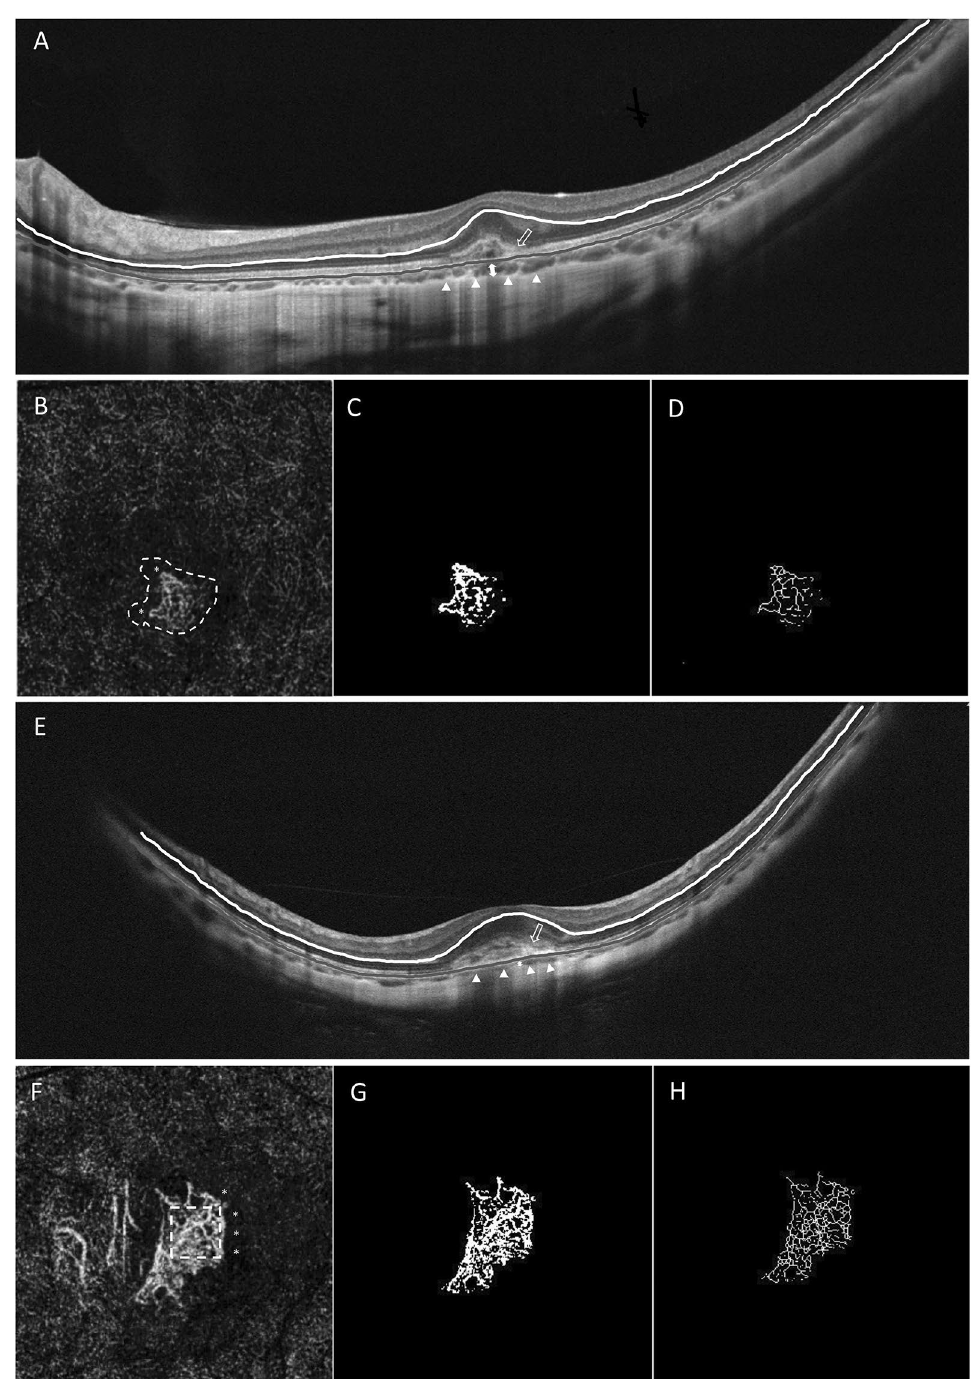
Figure 1. Baseline optical coherence tomography (OCT) and OCT angiography (OCTA) images of two patients with myopic choroidal neovascularization (mCNV). ( A ) This case is a 24-year-old female with an axial length of 29.20 mm. Baseline spectral- domain OCT B-scan shows a subfoveal choroidal thickness (SFCT) of 78.88 μm (double arrow). The choroid-scleral interface is indicated by white arrowheads. An ellipsoid zone disruption (graded 0) is found in the fovea (hollow arrow). ( B ) OCTA en-face image (3 × 3 mm) at baseline reveals a tangled-shaped NV with peripheral arcade/loops (*) and perilesional halo (white dashed line). The binarized and skeletonized image of the total NV lesion are showed in ( C ) and ( D ). Her baseline best-corrected visual acuity (BCVA) was 65 ETDRS letters, and improved to 85 EDTRS letters at 12 months after receiving one anti-vascular endothelial growth factor (anti-VEGF) injection. ( E ) This case is a 63-year-old female with axial length of 29.32 mm. Spectral-domain OCT B-scan at baseline shows an SFCT of 40.75 μm (double arrow). The choroid-scleral interface is indicated by white arrowheads. The absence of an ellipsoid zone (graded 1) is found in the fovea with haziness of the CNV border (hollow arrow). ( F ) OCTA en-face image (3 × 3 mm) at baseline shows a seafan-shaped NV with peripheral arcade/loops (*) and prominent branching vessels (white dashed square). The binarized and skeletonized image of the total NV lesion are showed in ( G ) and ( H ). Her BCVA was 70 ETDRS letters and 65 EDTRS letters at baseline and 12 months, respectively. She received a total of two anti-VEGF injections. The white lines in OCT B-scan represent the outer border of the outer plexiform layer, and the gray lines indicate the retinal pigment